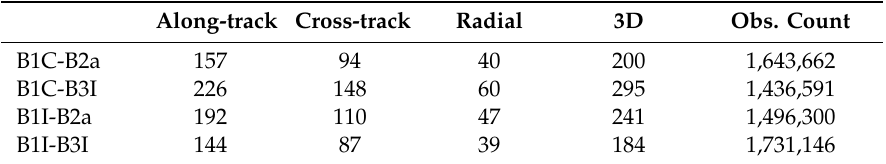
Figure 6. The root mean square (RMS) values of the two-day overlap in orbit determination using B1CB2a, B1CB3I, B1IB2a and B1IB3I in the along-track, cross-track, radial and 3D directions. The mean observation counts of four IF combinations in each arc are presented on the dual-Y axis. Table 5. The results of the overlap comparison of the BD3 two-day overlap in the along-track, cross-track, radial and 3D directions (units: mm). The mean observation counts used in each arc are listed in the last